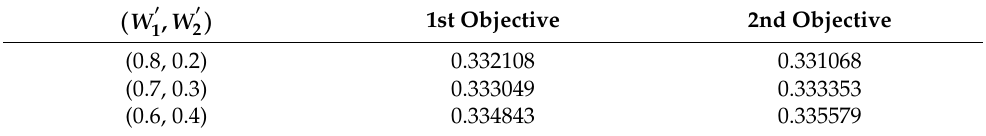
Table 6. Normalized decision-making matrix in Shannon